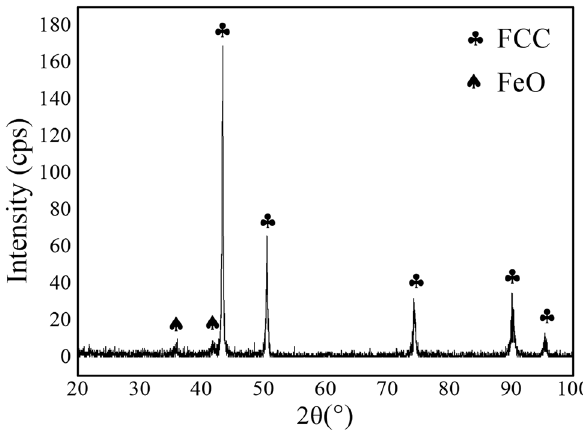
Figure 3: The XRD pattern of Co 28.5 Cr 21.5 Fe 20 Ni 26 Mo 4